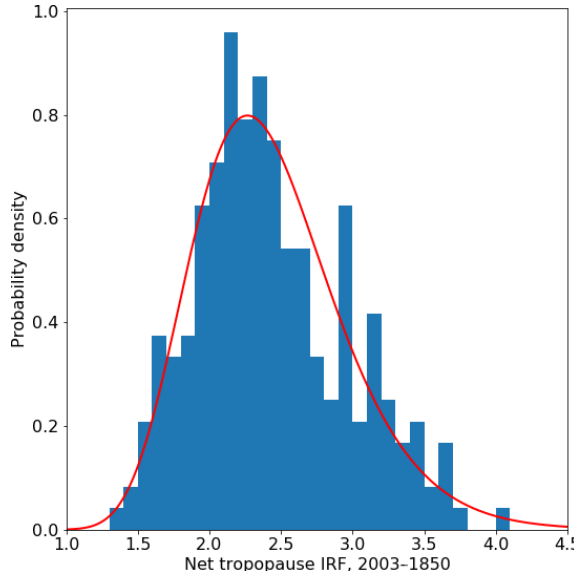
Figure 9. Probability density function for the global annual mean instantaneous radiative forcing (Wm − 2 ) for the year 2003, resulting from the CAMS Climate Forcing Perturbed Parameter Ensemble. A lognormal fit to the distribution is shown in